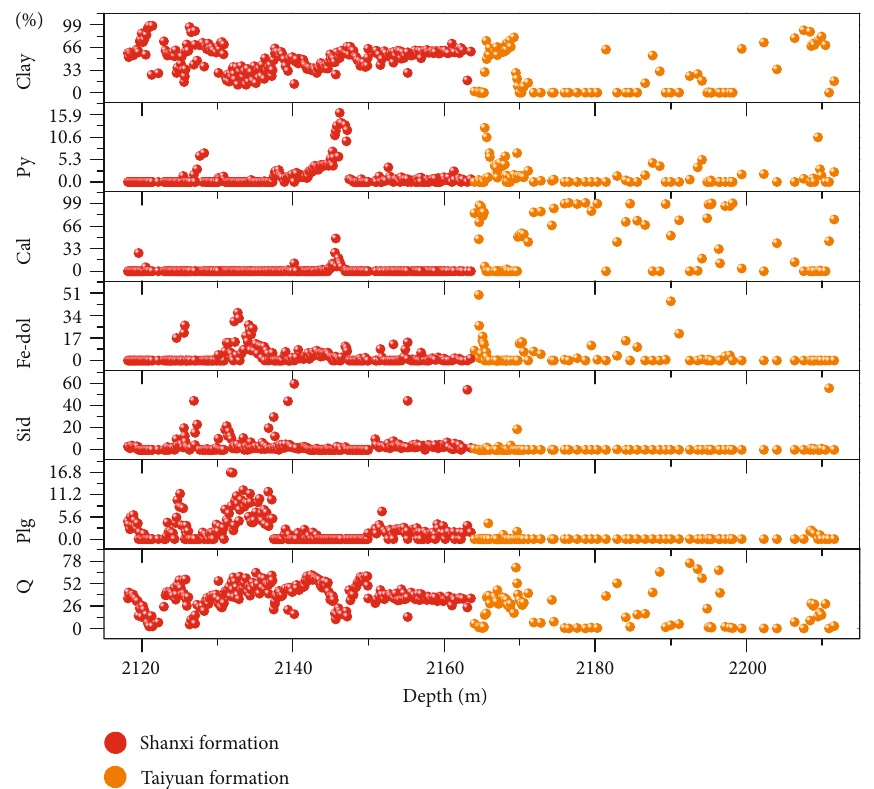
Figure 3: Showing the vertical distribution of various minerals in the Shanxi Formation and Taiyuan Formation in the Ordos Basin. Note: Q =quartz; Plg=plagioclase; Sid =siderite; Py =pyrite; Cal =calcite; Fe-dol =Fe-dolomite. Table 1: Mineralogical composition of representative samples of the Shanxi Formation and Taiyuan Formation in the Ordos Basin. Formation Quantity Quartz (%) Plagioclase (%) Siderite (%) Fe-dolomite (%) Calcite (%) Pyrite (%) Clay (%) Min 2.3 0 Shanxi